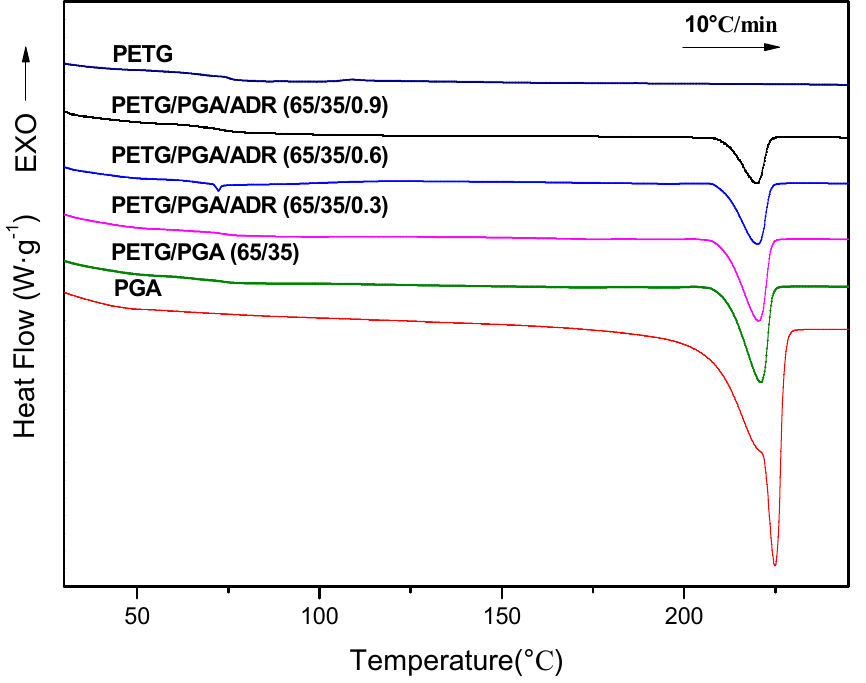
Figure 14. Heating DSC thermograms for neat PETG, PGA, and PETG/PGA/ADR (65/35/x) sam- ples.